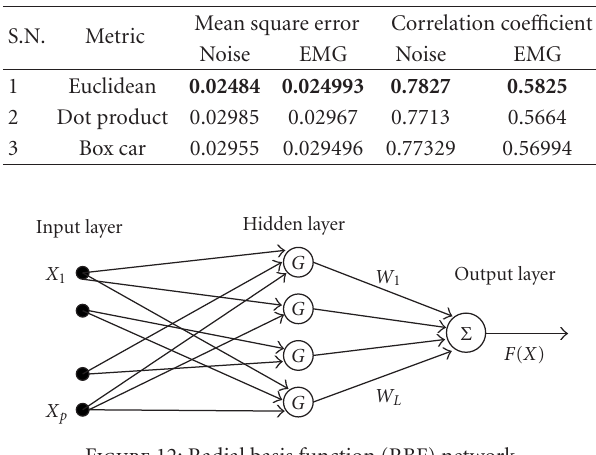
Table 11: Selection of competitive learning metric for RBF NN model.